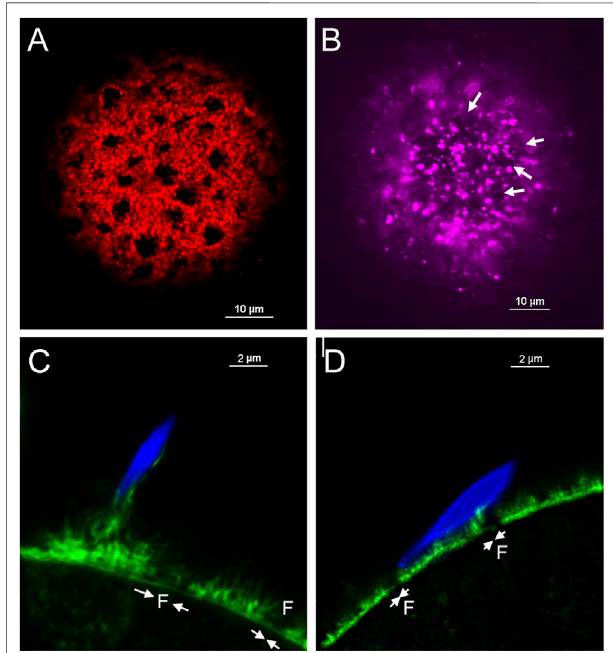
FIGURE 3 | Fixed and Live cell imaging of fenestrae in the cortical actin layer.Oocytes with bound/fused sperm from mated females were fi xed and labelled with alexa-Fluor 568 (A) . Live oocytes with partially incorporated sperm were selected from mated females and labeled with SiR-actin as described in Methods, (arrows indicate the position of some of the fenestrae) (B) . Oocytes fertilized in vitro (n = 19) were fi xed and labelled with alexa-Fluor 568phalloidinthenimagedbySTEDmicroscopytoobservethedistributionof microvilli at the sperm binding site. Examples include a supernumerary sperm bound to an oocyte already containing an incorporated sperm (C) , and an unfertilized (no incorporated sperm found) oocyte with a bound or fusing sperm (D) . Arrows indicate the presence of fenestrae. Magni fi cation is indicated by the bars.